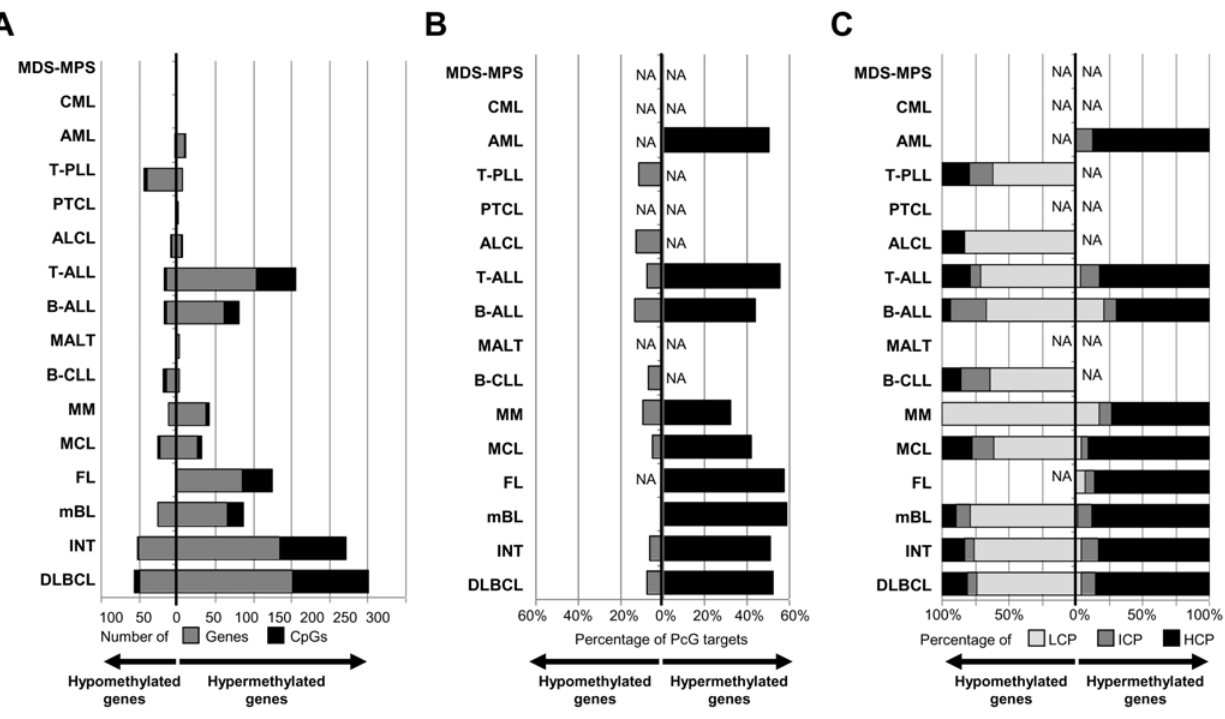
Figure 3.Bar plot of the differentHNs under studyshowing foreach entity. (A) The number of genes/CpGs hypermethylated orhypomethylated, (B) the percentage of differentially methylated genes marked by the PRC2 in ESCs, and (C) the percentage of differentially methylated genes showing distinct promoter subtypes according to their CpG content. LCP: low CpG content, ICP: intermediate CpG content, HCP: high CpG content.